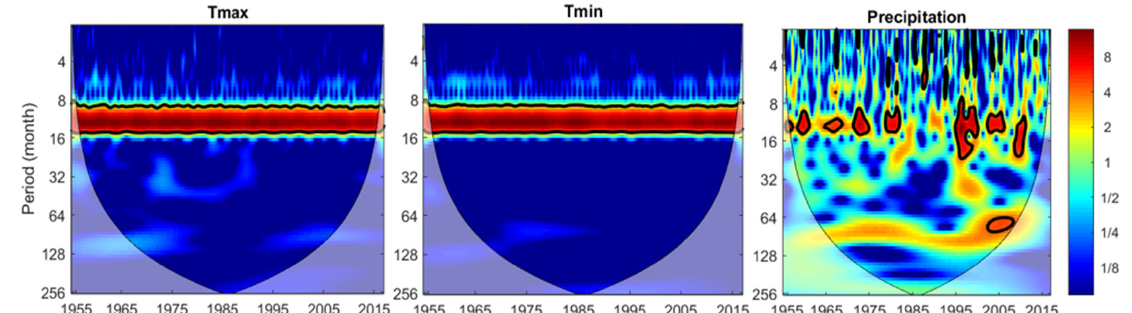
Figure 8. Continuous wavelet transform (CWT) of T max , T min and precipitation time series during 1955–2016. Thick contours denote 5% significance levels against red noise.